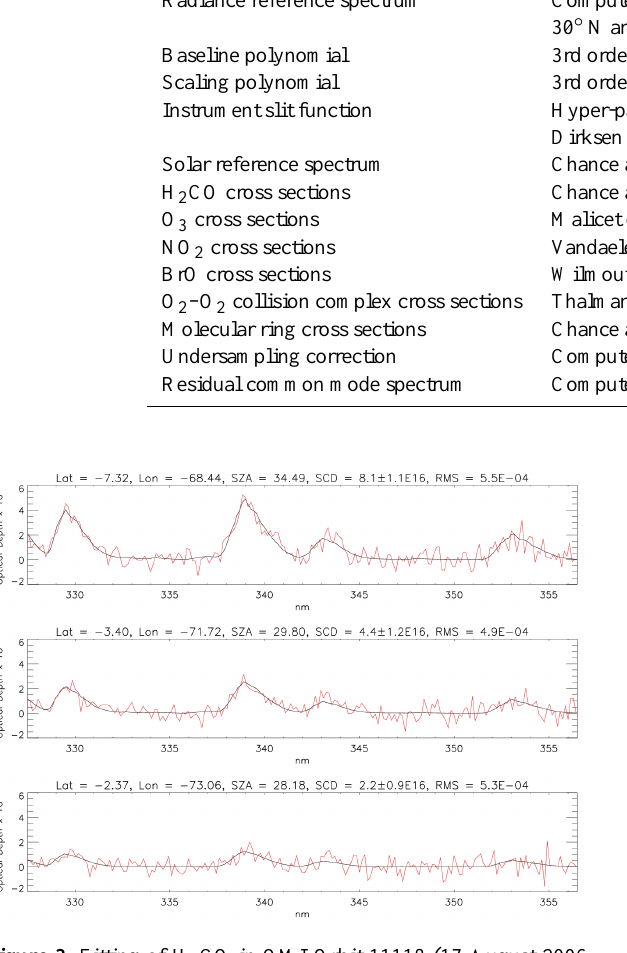
Figure 3. Fitting of H 2 CO in OMI Orbit 11118 (17 August 2006 overpass over South America) for high (top), medium (middle), and low (bottom) amounts. The black line is the fitted H 2 CO optical depth, and the red line is the fitted H 2 CO optical depth plus the fitting